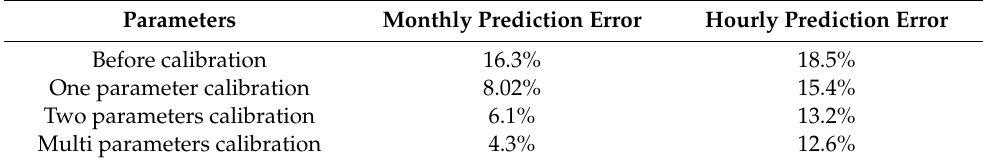
Table 4. Prediction result comparison among different number of parameters to be calibrated.